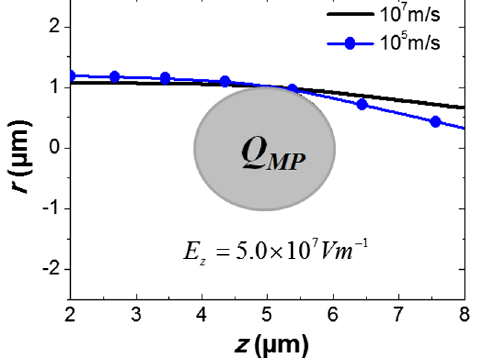
FIG. 6. Primary electron trajectories passing close to the MP for two velocities. The deflection occurs only very close of the